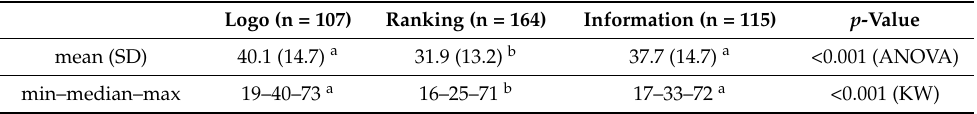
Table 1. Mean age (ANOVA 1 ) and median age (KW 2 ) of groups expressing a certain menu label preference (logo, ranking, or